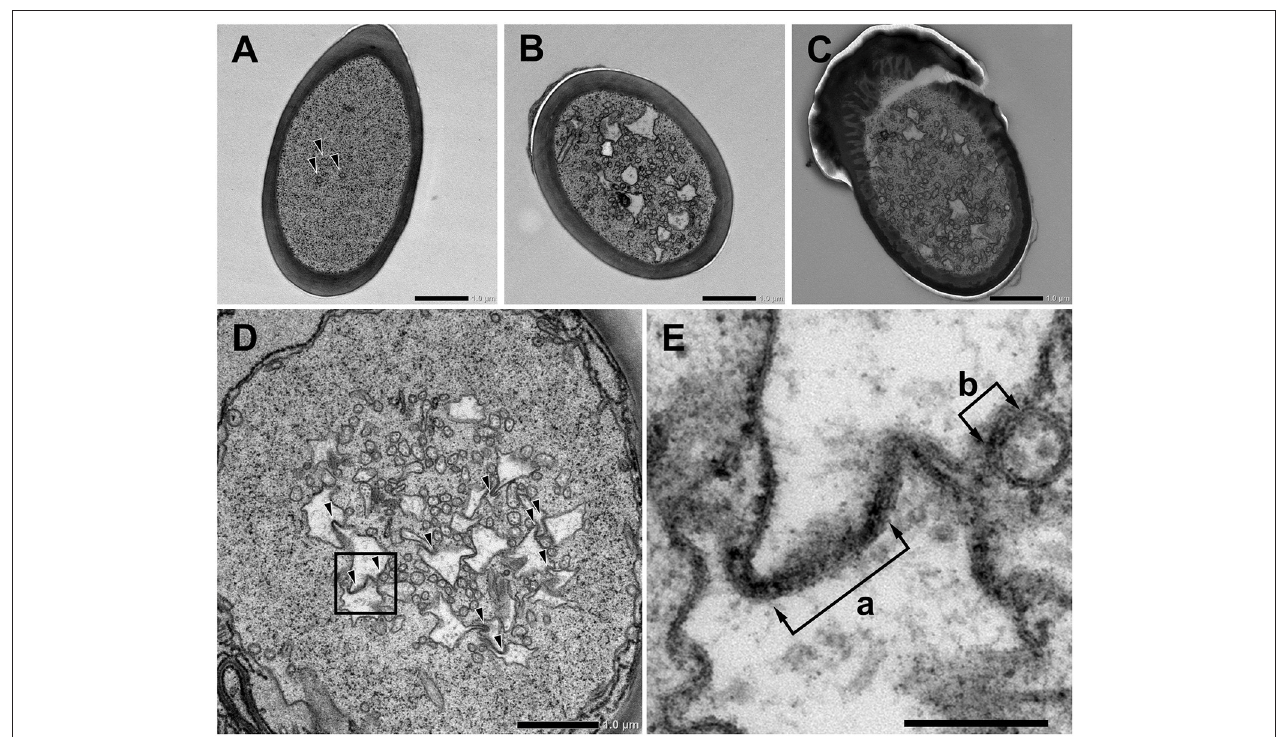
FIGURE 2 | Transmission electron microscope images of Sensilla basiconica and adhesion between olfactory receptor membranes. (A–C) Cross images of ultra-thin sections of an S. basiconica of C. japonicus worker ant. Three sections are at the middle of the sensillar shaft, where few dendritic processes are seen (A) , more proximal (B) and the level of basal socket, where many dendritic processes are seen (C) . (D) A cross section beneath the antennal cuticular surface. (E) High magnification image of a square of (D) , showing adhesion between adjacent membranes (double-headed arrows). Bars indicate 1 µ m in (A–D) and 200nm in (E)